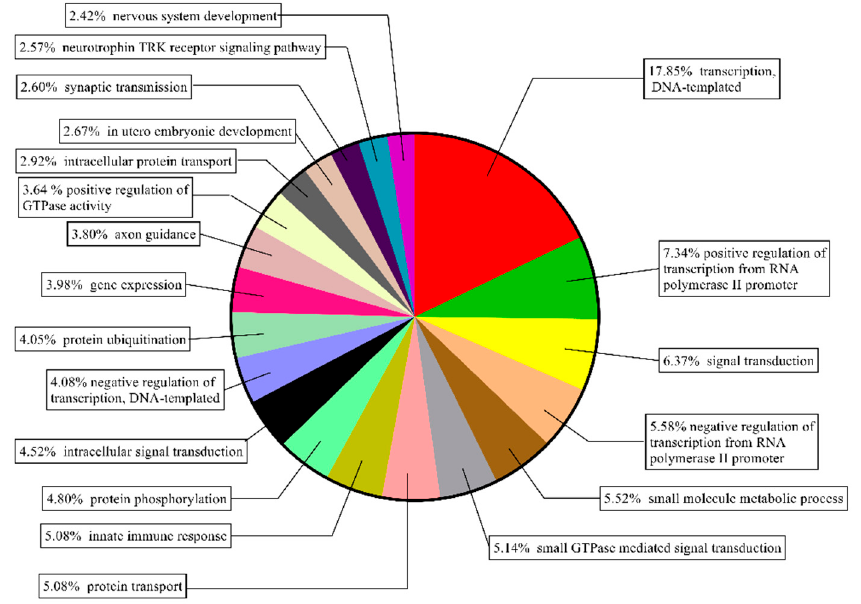
Figure 6. Gene ontology analysis (biological process) of differentially expressed genes between Yunling and Leiqiong cattle pituitary glands. (The top 20 enriched gene ontology (GO) biological process terms ( p < 0.05. Each color represents a term.). Table 2. Information on differentially expressed genes’ enrichment pathways.